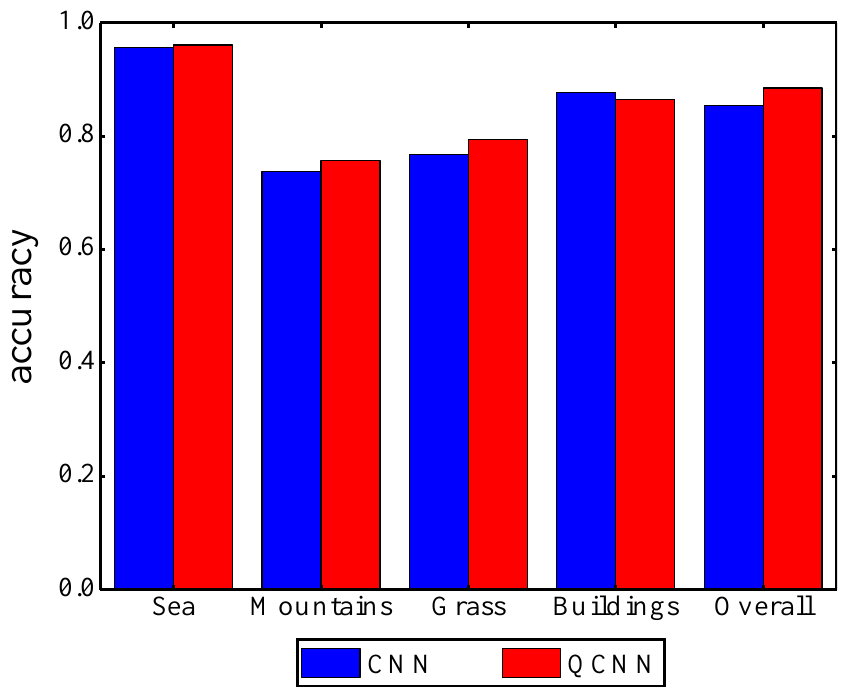
Figure 15. The classification accuracies by CNN and QCNN on San Francisco data